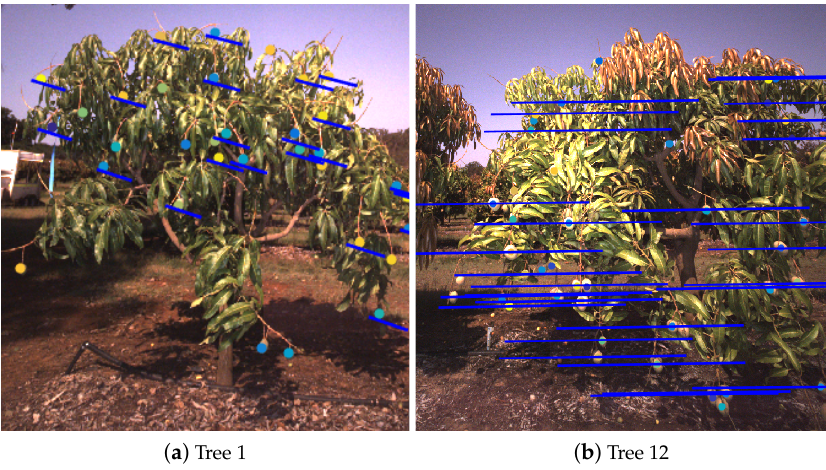
Figure 19. Examples of two trees where the base and repeated counts differed. The dots and the blue lines indicate tracked fruit and projections. When capturing the image in ( a ); the vehicle was oscillating rapidly. Immediately prior to capturing the image in ( b ), several images in the sequence were missing due to a logging error, resulting in longer projection